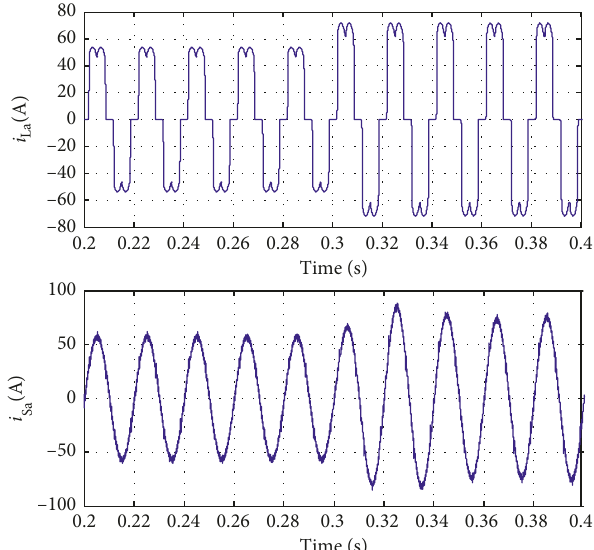
Figure 19: Waveforms of load current and source current in the case of abrupt